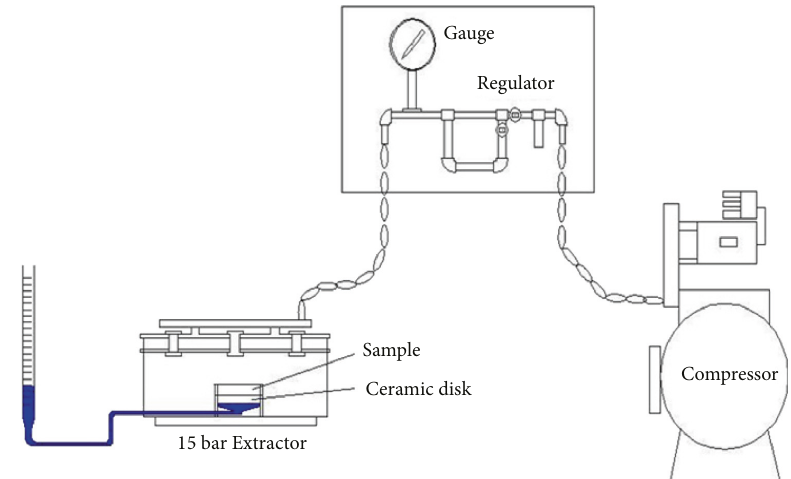
Figure 3: Pressure plate